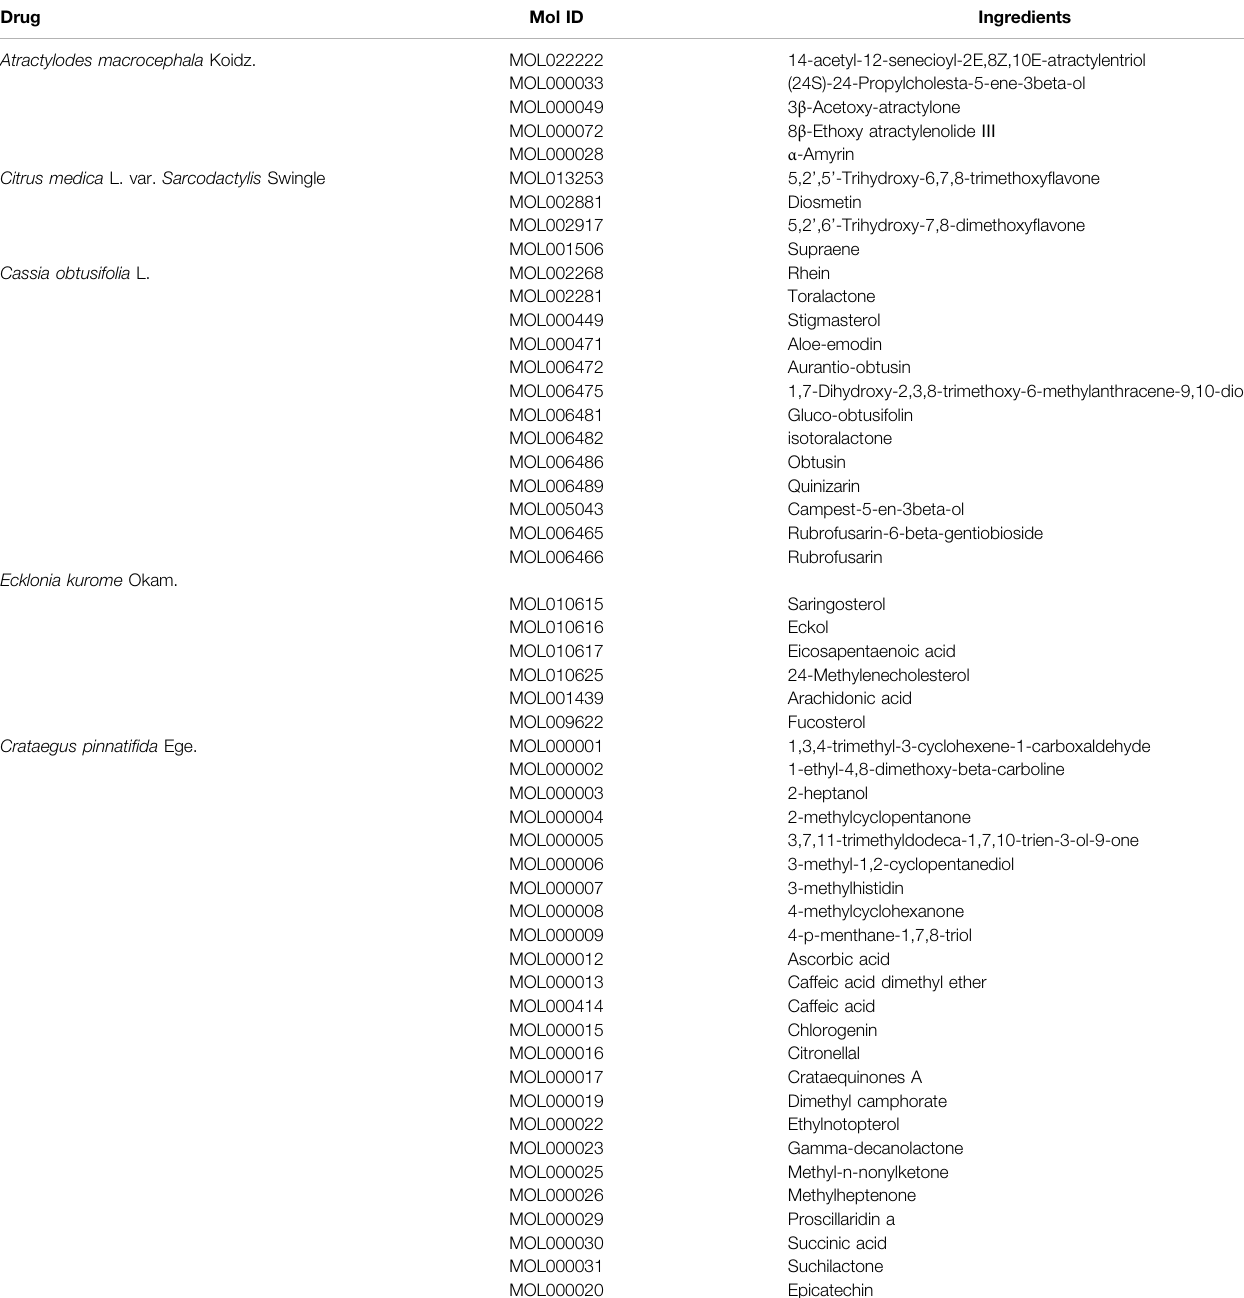
TABLE 3 | The ingredients in KD-compound-target network. Drug Mol ID Ingredients Atractylodes macrocephala